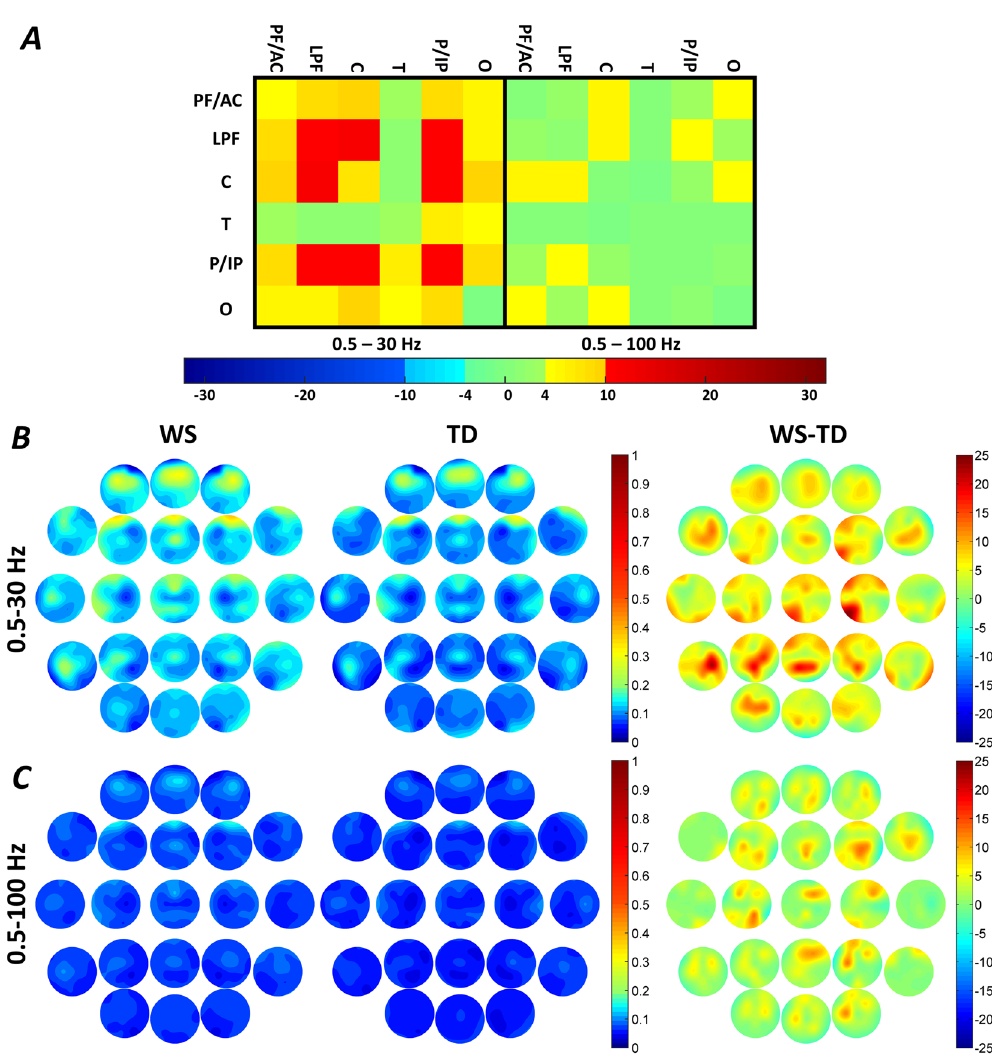
Figure 2. Region-specific NREM sleep EEG broadband-1 (0.5–30 Hz) and broadband-2 (0.5–100 Hz) WPLI differences. ( A ) Broadband-1 WPLIs are significantly higher in Williams syndrome as compared to the typically developing group in several intra- and inter-regional pairings. Color codes: Red = Williams syndrome > typically developing (B-H corrected), Yellow-orange = Williams syndrome > typically developing (uncorrected), Green = Williams syndrome ≈ typically developing, Light blue = Williams syndrome < typically developing (uncorrected), Blue = Williams syndrome < typically developing (B-H corrected). ( B , C ) Broadband-1 and broadband-2 WPLI maps highlighting the patterns of absolute group means (left: Williams syndrome; middle: typically developing) and Williams syndrome-typically developing differences (right). Positions of the maps represent the seed derivation of the synchronization analyses (according to the 10–20 system), while the color patterns are the representations of the variable strengths in the synchronization (WPLI) between the respective region and the seed